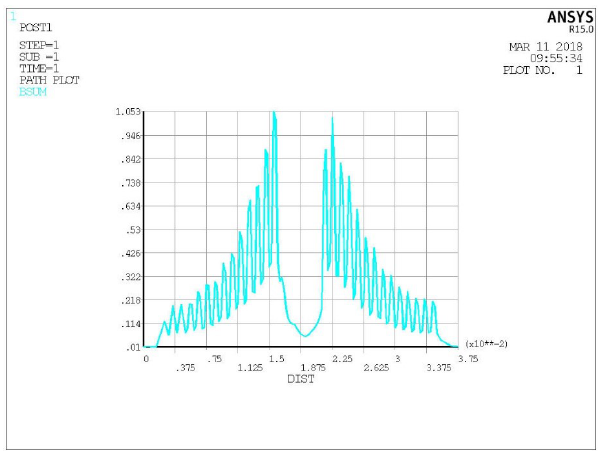
Fig. 11 Distribution of B in the seal gap between split pole shoes and shaft in the case when magnetic sealant is used to bond the split pole